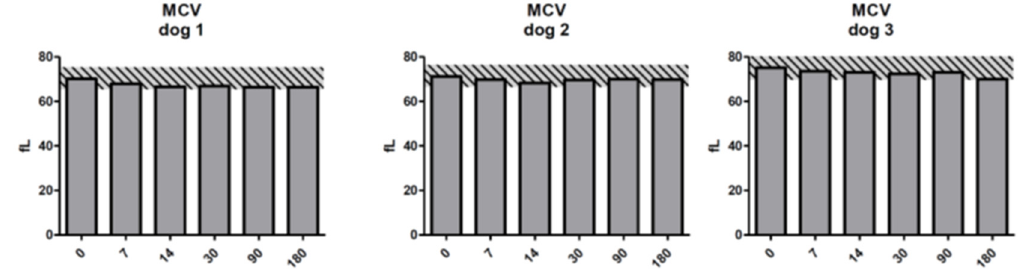
Figure 3. Mean corpuscular volume (MCV) for the dogs on days 0–180 post treatment with 213 Bi-400-2 antibody. Shaded areas show reference change values (RCVs). X axis shows days post injection of radiolabeled antibody.